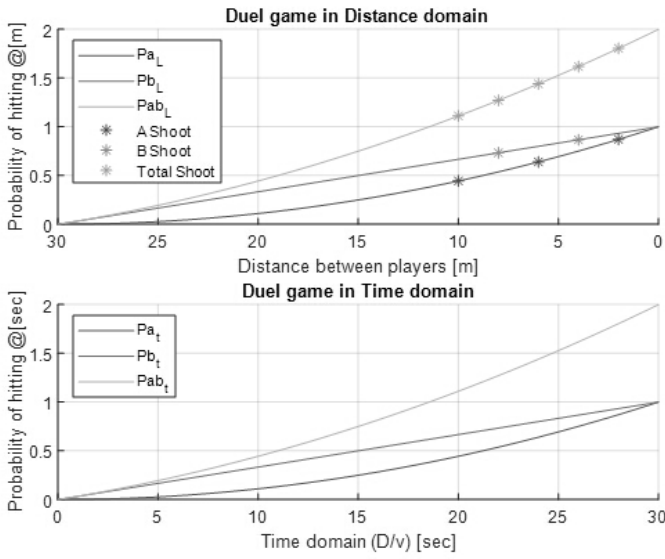
Figure 3. Probability of hitting in the distance and the time